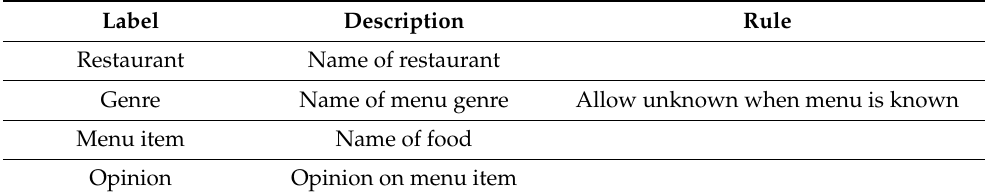
Table 6. Context used in dialogue to specify